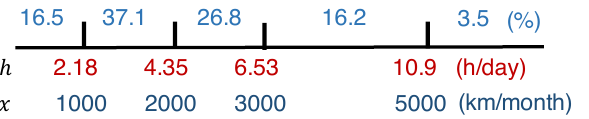
Figure 2. Distribution example of the driving distance x (KEPRI, 2022). Average driving distance per month is 1889 km ( x = 60.9